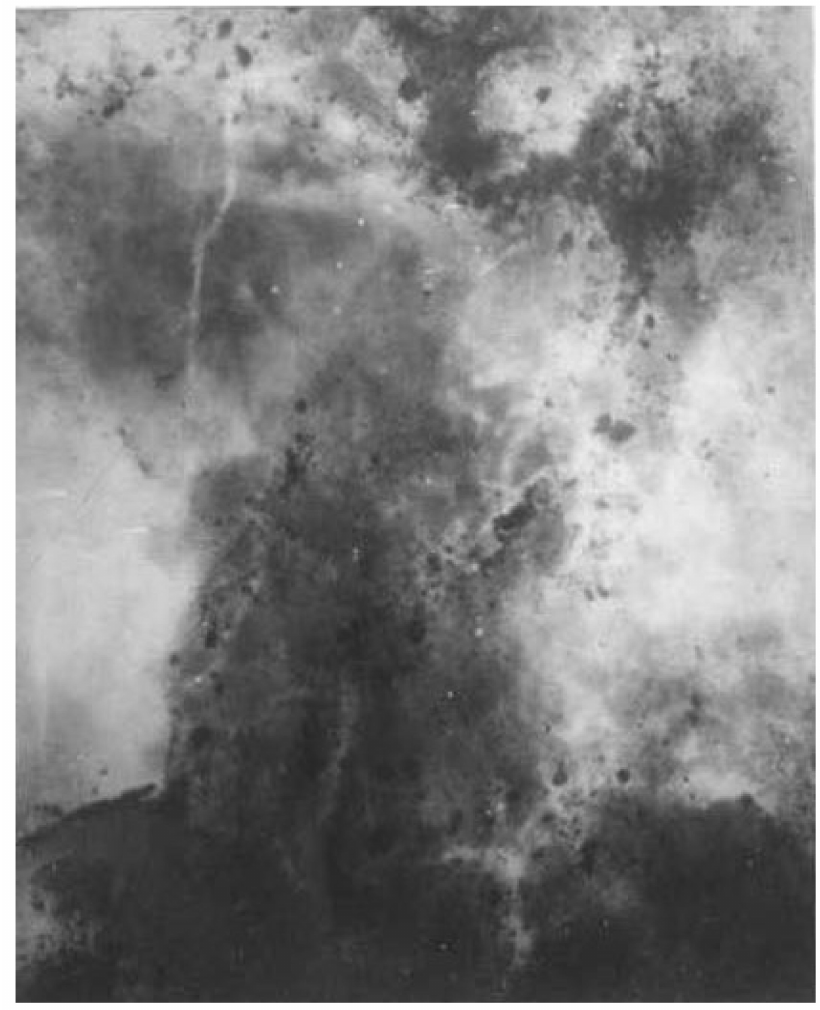
Figure 4. X-ray diffraction in soil on barium sulfate particles after PMS–70 intra-soil